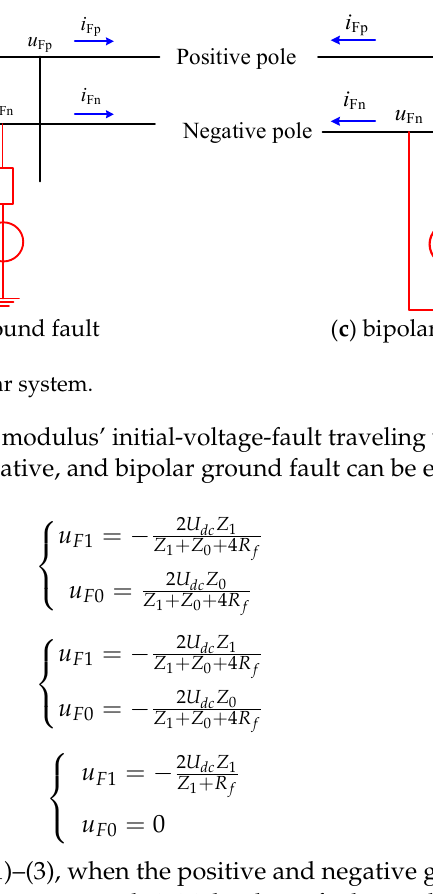
on the DC line, the corresponding zero-mode initial-voltage-fault traveling wave polarities Figure 4a shows the schematic diagram of the HVDC network line boundary. For the are positive and negative, respectively. When a bipolar short-circuit fault occurs, the corresponding zero-mode initial-voltage-fault traveling wave is zero. Therefore, fault pole selection can be effectively performed based on the zero-mode fault traveling wave. For these three faults, there is a negative polarity of the initial-voltage-fault line wave, so the fault line can be discerned based on the polar-mode line wave. Figure 4a shows the schematic diagram of the HVDC network line boundary. For is represented by the unit step function − ε (t). When the influence of line resistance, conductance and frequency variation characteristics of line parameters are ignored, the initial-fault traveling wave from the fault point will propagate along the line without attenuation and distortion of the line boundary.